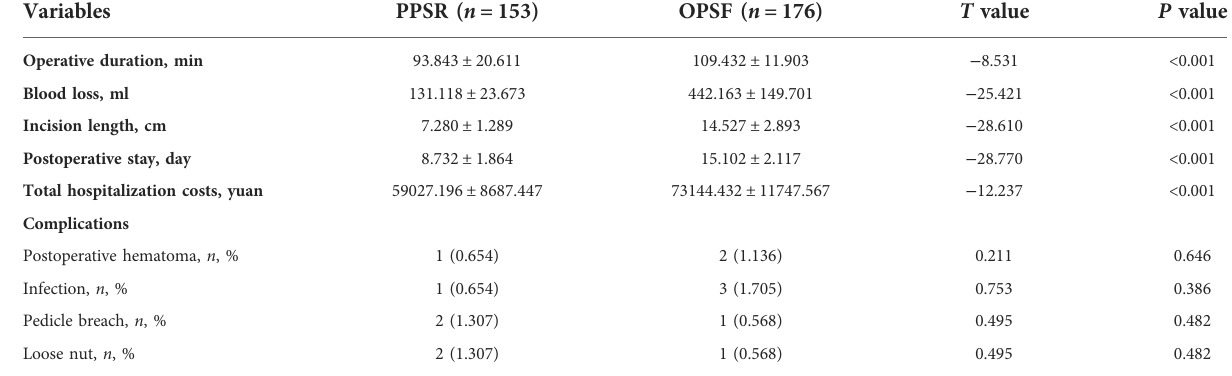
TABLE 2 Periprocedural data for PPSR and OPSF groups.